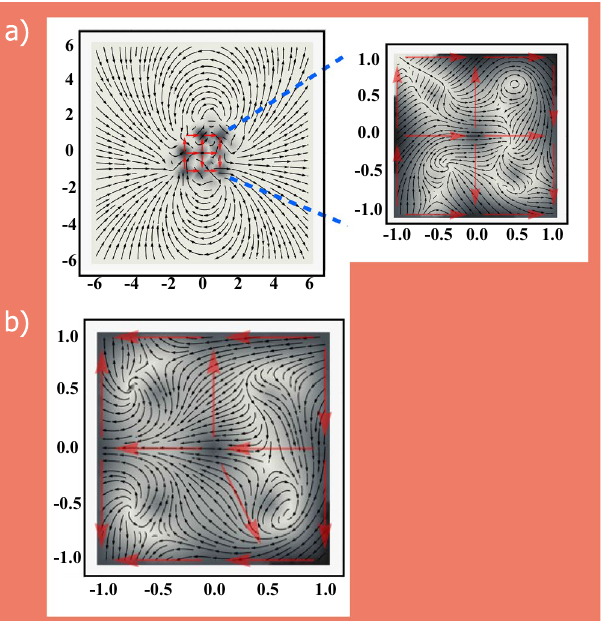
Figure 4. Magnetic field lines for stained glass ( a ) and deformed stain glass window ( b ) samples. ( a ) Shows the far-field image data. The inset exemplifies the zoomed near-field data. ( b ) Shows near field data of the deformed window. The length scales for both figures are in units of the lattice constant of the artificial